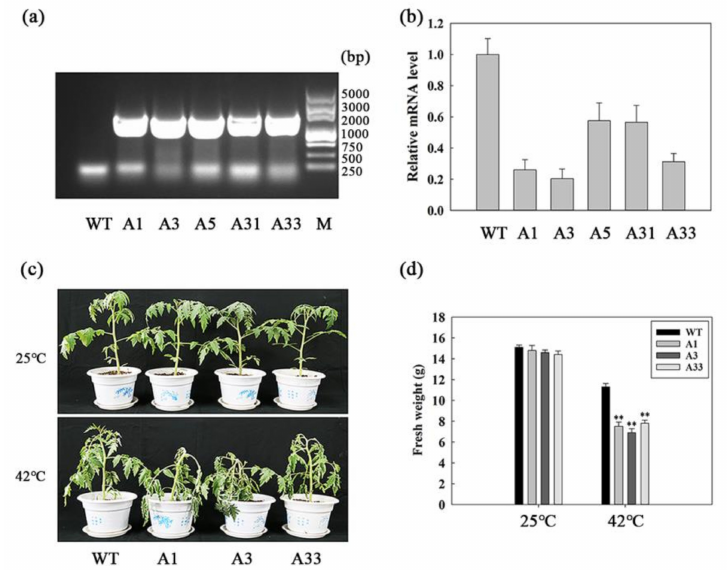
Figure 4. Identification of the AS transgenic tomato and the phenotype analysis of WT and AS lines under heat stress. ( a ) Identification of SlEGY2 AS lines using PCR. ( b ) The relative mRNA level of SlEGY2 in WT and AS lines. ( c ) The phenotype of WT and AS lines. ( d ) Fresh weight of WT and AS lines. ** ( p < 0.01) indicate significant differences relative to the WT plants.